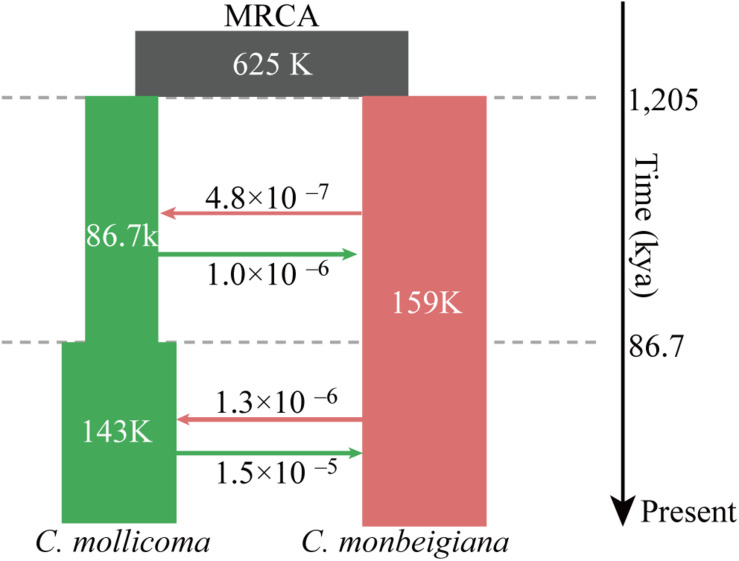
Schematic of demographic scenario modeled using fastsimcoal2. Split times (kya), population size, and migration rates corresponding to 95% CIs obtained from this model are shown in Supplementary Table 3. Estimates of gene flow between populations are given as the migration fraction per generation. The top black square was the most recent common ancestor (MRCA) to C. monbeigiana and C. mollicoma.